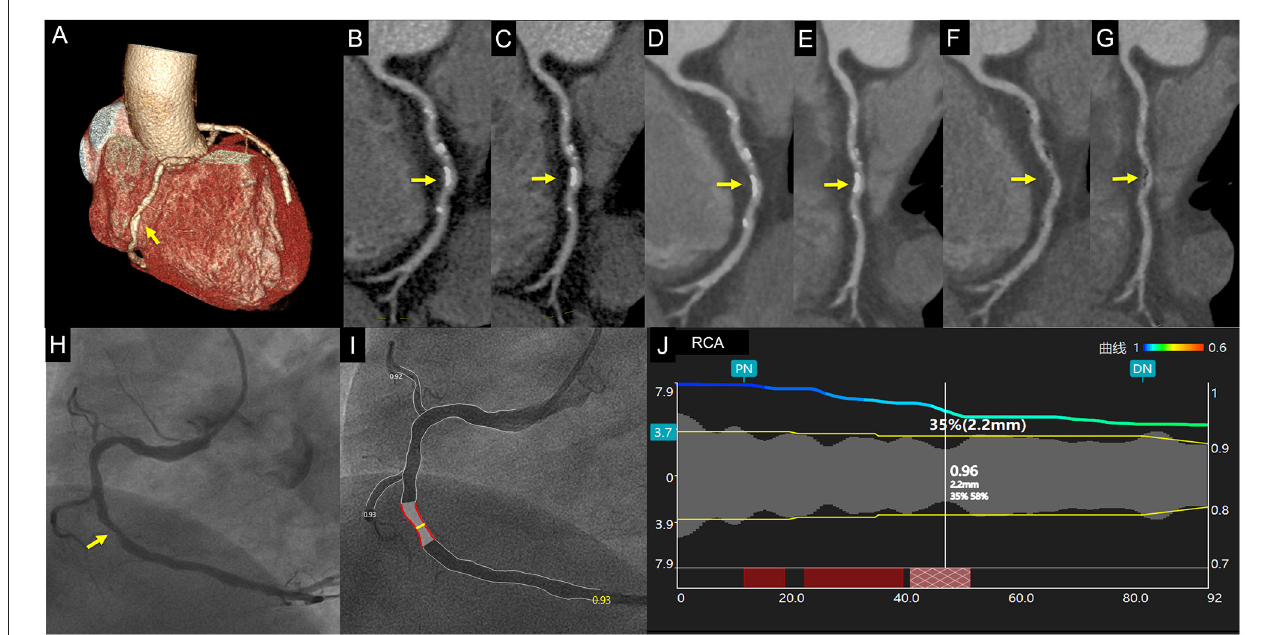
FIGURE 2 | Case 1. A 67-year-old man with chest distress. Volume rendering and curved multiplanar reformation of traditional CTA HLR (A–C) images show ∼ 50% stenosis of the middle right coronary artery caused by calcified plaque. CTA DLR (D,E) images show superior image quality yet a similar degree of stenosis. CTA sDLR images of corresponding position (F,G) show 35% stenosis. Invasive coronary angiography (H) and quantitative coronary angiography (I,J) confirm the stenosis degree of 35%. Written informed consent was obtained from an individual for the publication of any potentially identifiable images or data included in this article. The yellow arrow shows the location of coronary